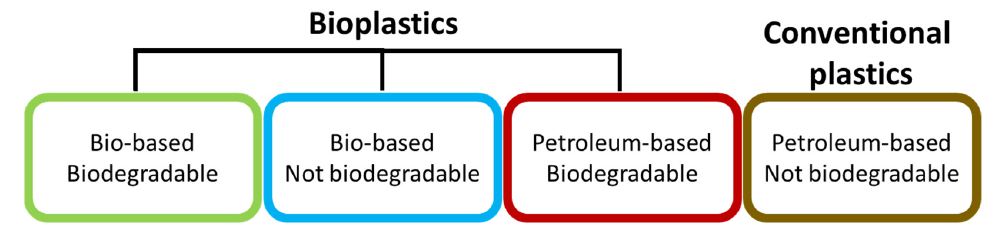
Figure 6. Classification of plastics according to origin and biodegradability.